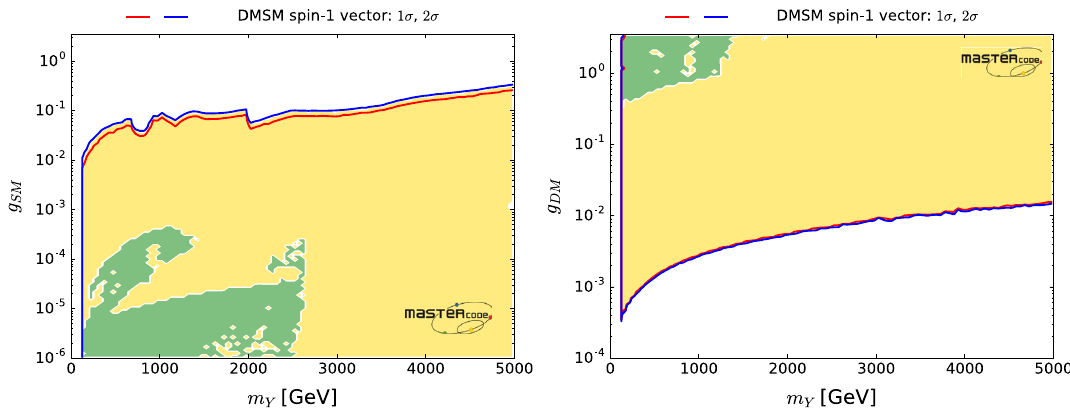
Fig. 6 The likelihood functions for g SM (left panel) and g DM (right panel) as functions of m Y in the vector-like model. We again use colour coding to illustrate the dominant mechanisms bringing the DM density into the allowed range: green for annihilation via t -channel χ exchange